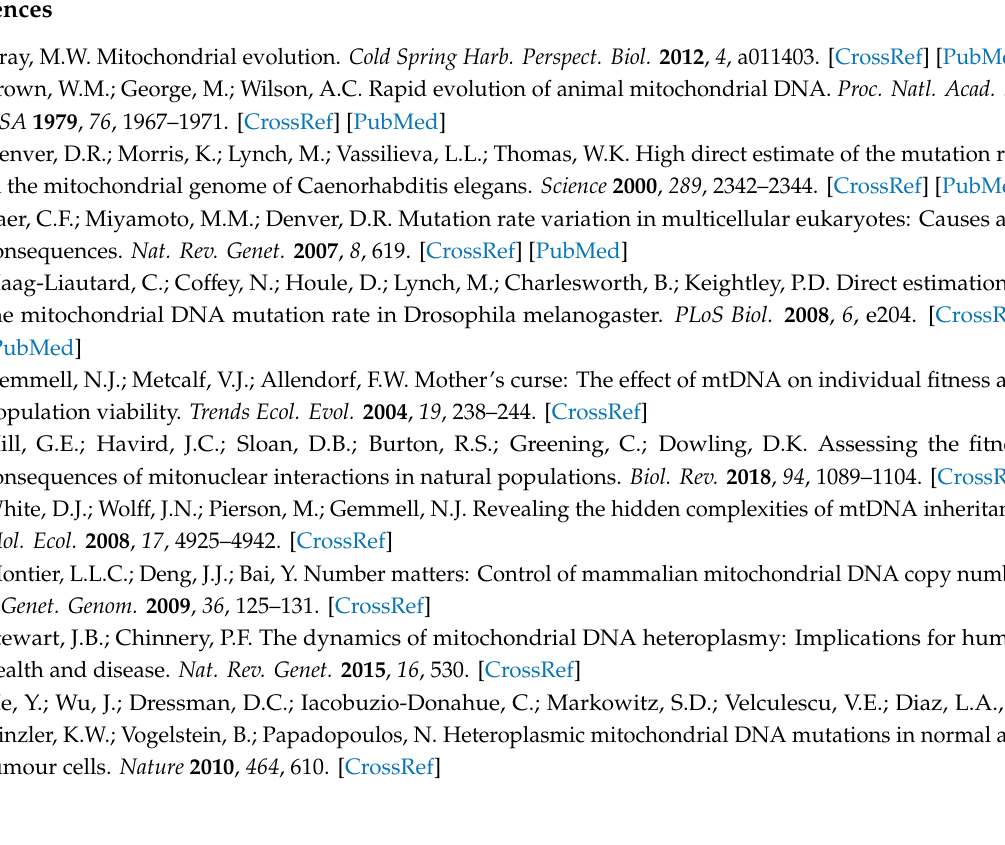
Figure S1: Representative alignment of AF16 MA13 demonstrating split-read mapping across the deleted ψ nad5-2 and nduo-5 region of the AF16 reference mtgenome, Figure S2: Conserved nDNA regions used for normalization in AF16 and ED3101 lines, Table S1: Excel spreadsheet containing raw read statistics, raw read counts for all mtDNA positions containing an identified significant polymorphism found in at least 1 line, and pairwise similarity of nDNA sequence regions used for mtDNA